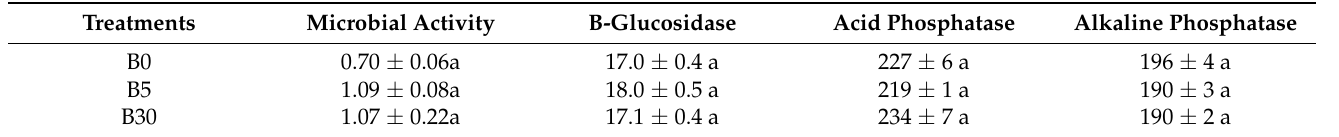
Table 2. Microbial activity, and enzyme activity of glucosidase, phosphatase of lower layer under biochar amended 0.3% (B5), 1.8% (B30) and not-amended in the upper layer (B0) after 16 weeks of mung bean residue incorporation.